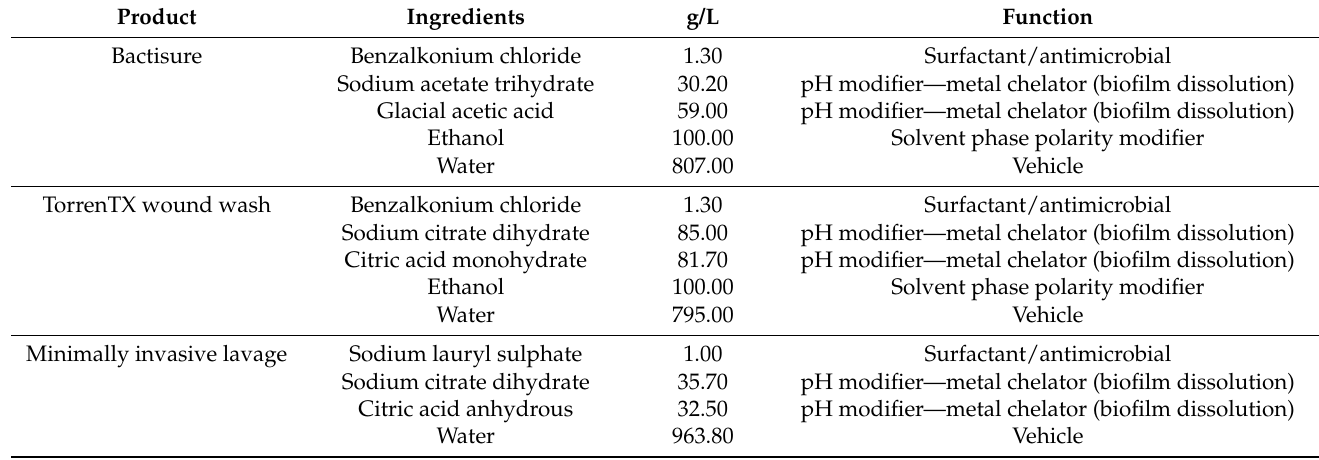
Table 1. Composition of antiseptic